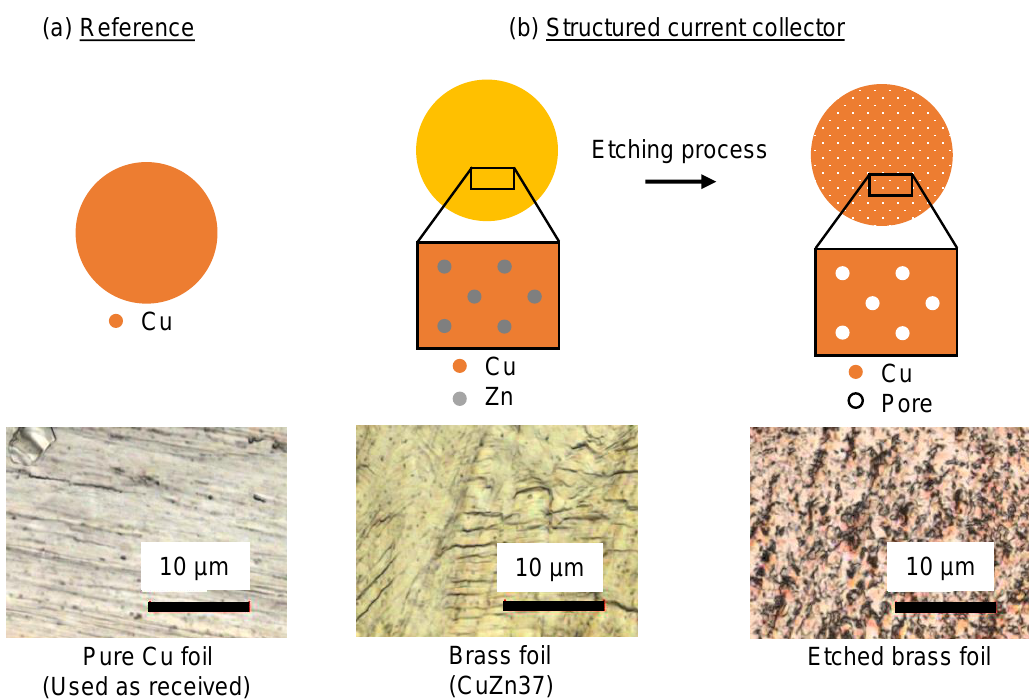
Figure 2. Schematic representation of the metal foils that are used as current collectors for Li electrodes in this work. ( a ) The reference is a pure and untreated Cu foil that is used as received. The microscope image is taken at a magnification of 150. ( b ) The structured current collector is manufactured by chemically etching CuZn foil in HCl. This procedure removes all solid Zn from the foil and leaves a porous foil made of pure Cu. The microscope images are taken at a magnification of 150 and show the CuZn foil prior to and after the etching